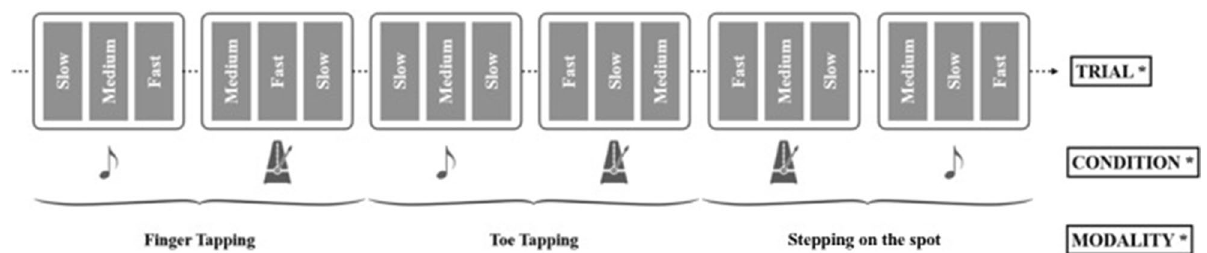
Figure 3. Diagrammatic representation of the experimental design.